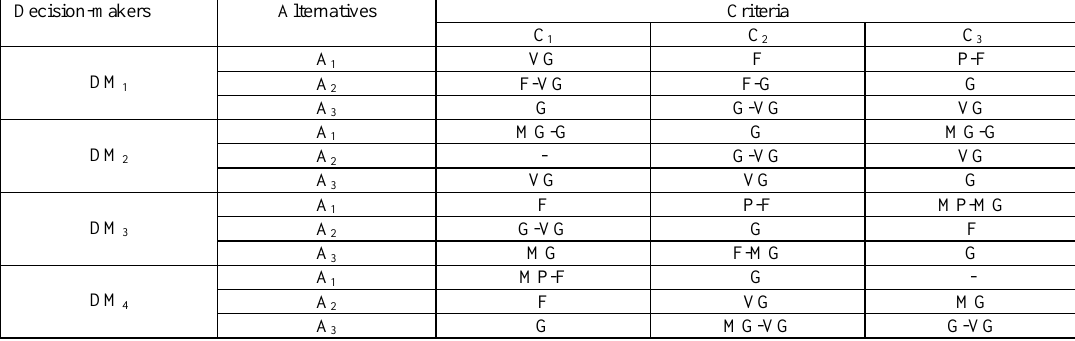
Table 1. Decision-makers’ evaluations of the three robots under subjective criteria